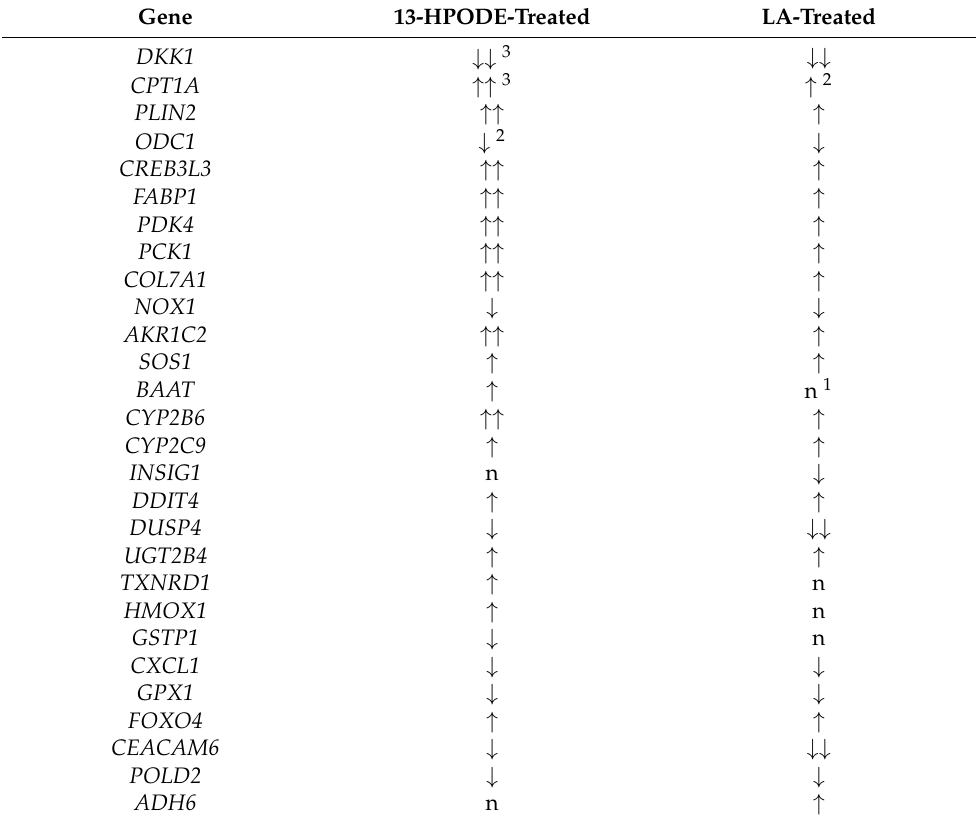
Table 3. Comparative differential gene expression. Comparison of differential expression ( ↑ up- regulation or ↓ downregulation) of selected genes in the two treatment cell groups relative to the untreated cell group. Gene 13-HPODE-Treated LA-Treated